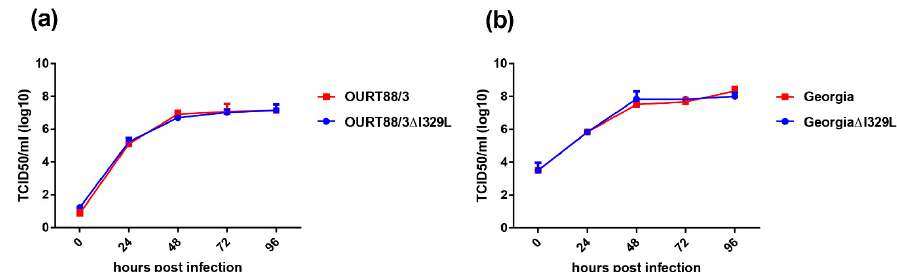
Figure 2. Deletion of the I329L gene does not reduce the replication of the OURT88 / 3 ( a ) and Georgia 2007 / 1 ( b ) strains in primary porcine bone marrow cells. Virus titres in TCID50 / mL on the y axis from cultures of porcine bone marrow cells infected for times between 0 and 96 h (x axis) with wild-type (red) or ∆ I329L (blue) viruses at a low multiplicity of infection.